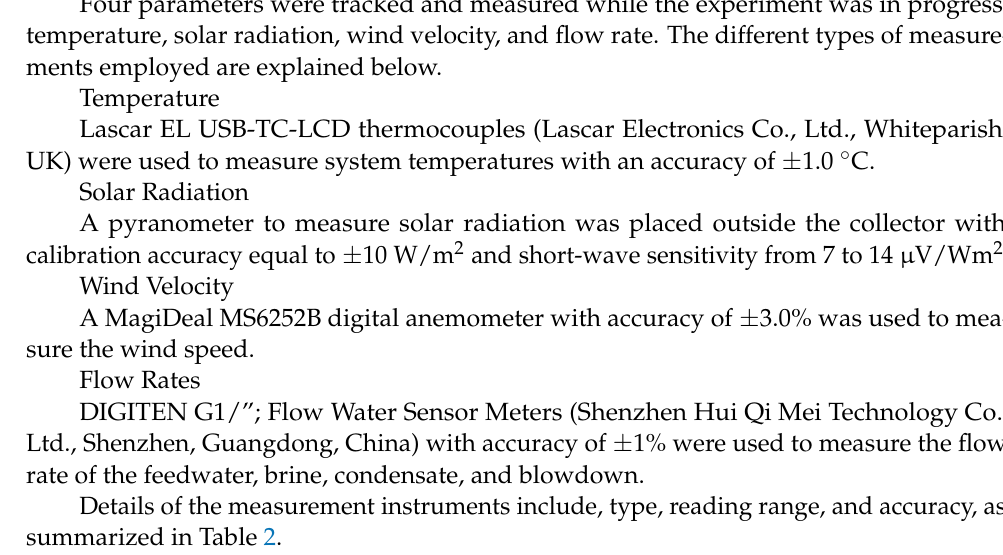
Table 2. Specifications of the instruments used in the experiments.